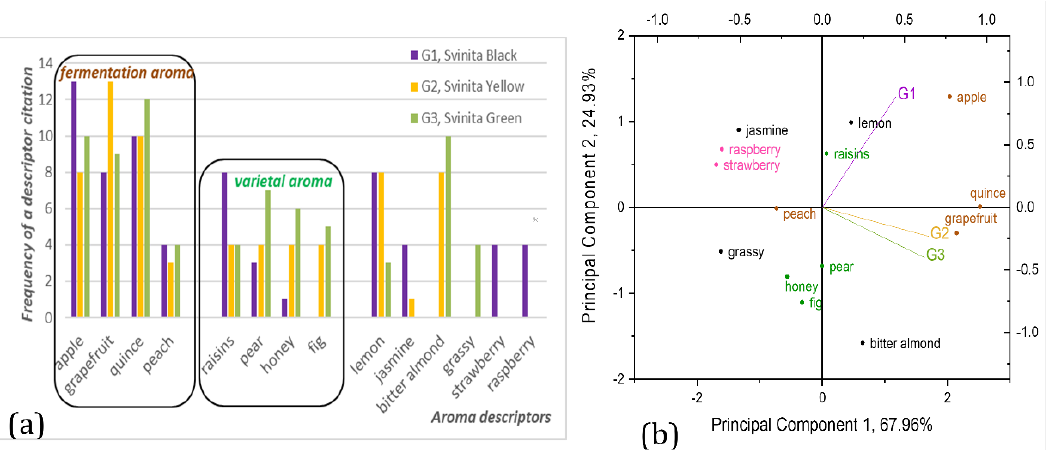
Figure 5. Frequency of aroma descriptor citations ( a ) and principal component analysis based on the frequency of aroma descriptor citations ( b ) for the beverages from fig varieties G1 – G3.